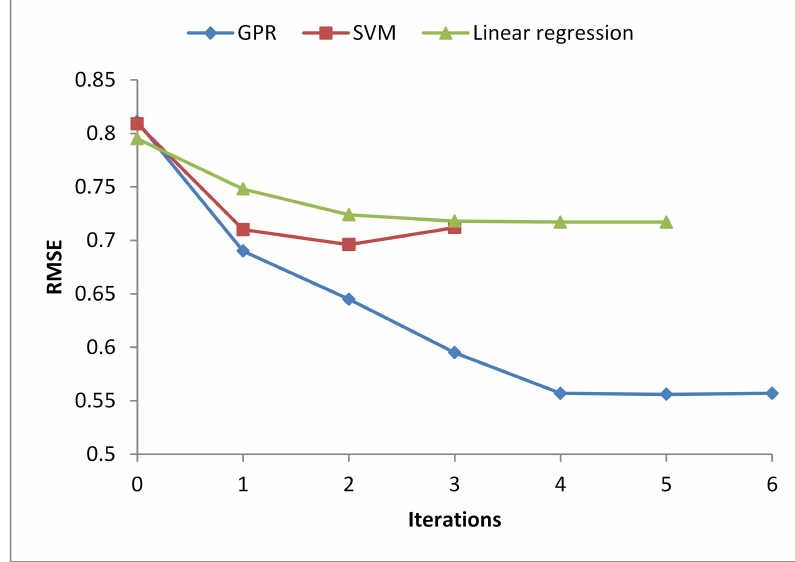
Figure 3. The iteration processes of feature selection.